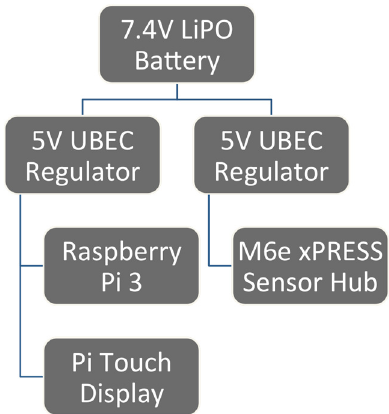
Figure 3. Power distribution diagram for the handheld unit.